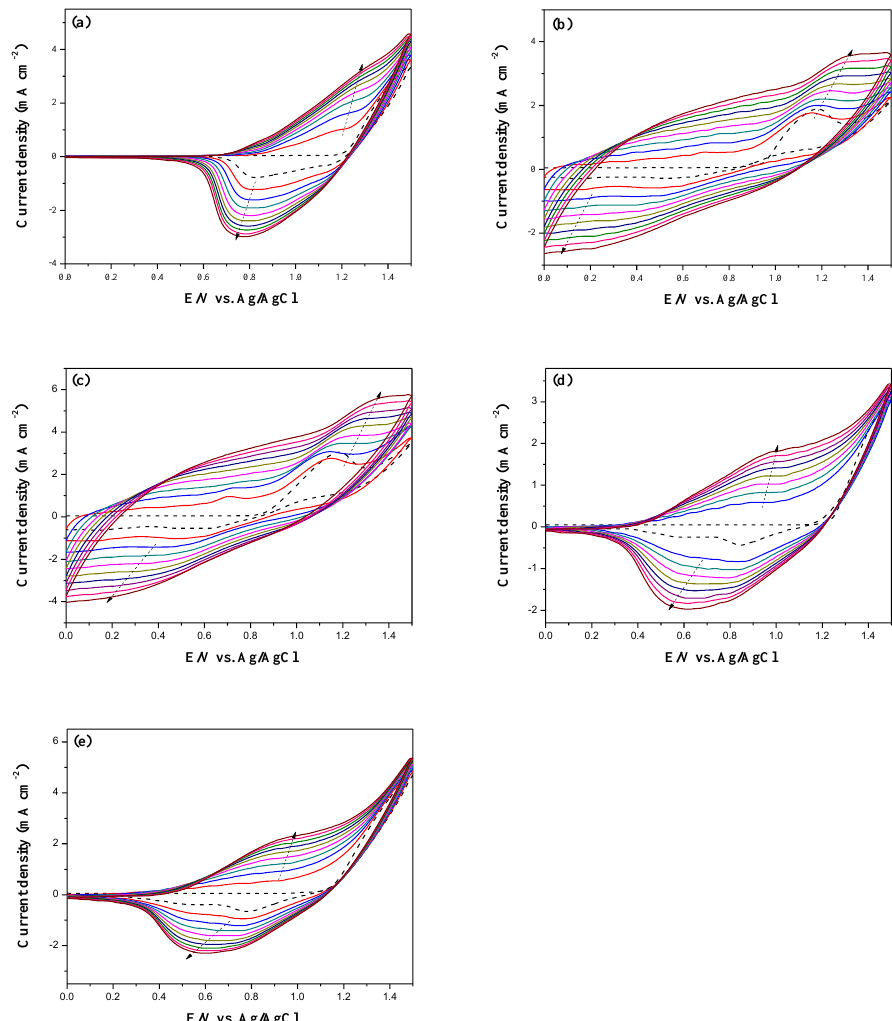
Figure 3. Electrochemical synthesis of ( a ) PDiCP; ( b ) P(DiCP- co -CPDT); ( c ) P(DiCP- co -CPDT2); ( d ) P(DiCP- co -CPDTK); and ( e ) P(DiCP- co -CPDTK2) in ACN/DCM (1:1, by volume) solution at 100 mV s − 1 on the ITO working electrode.